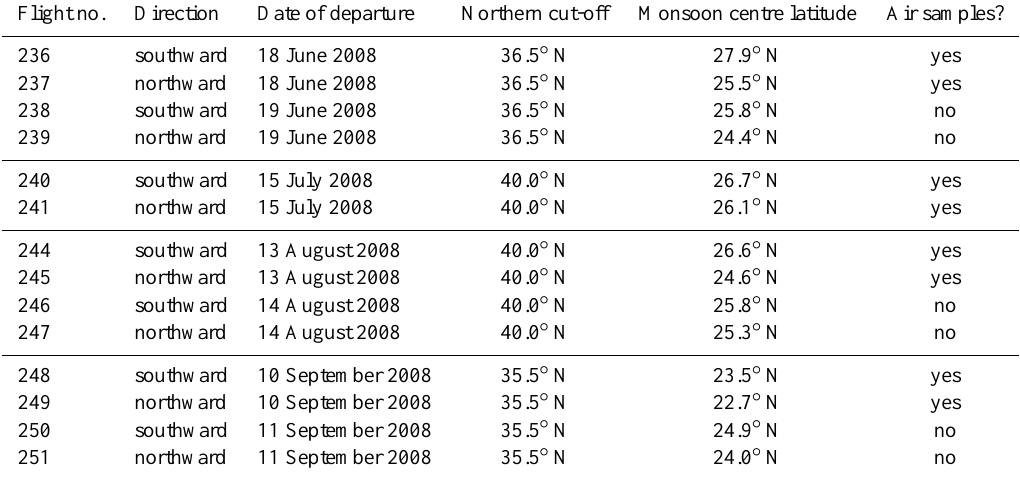
Table 1. CARIBIC2 flights to Chennai, India, in 2008. Listed are the flight number, date of departure and flight direction. Column 4 gives the northern cut-off for the trajectory analysis which was selected for each month to exclude trajectories belonging to the eastward jet stream. Column 5 lists the latitude of the wind reversal along each flight track which is used as an indicator of centre latitude of the monsoon UTAC at flight altitude (see Fig. 4). The last column indicates whether air samples have been collected or not. Flight